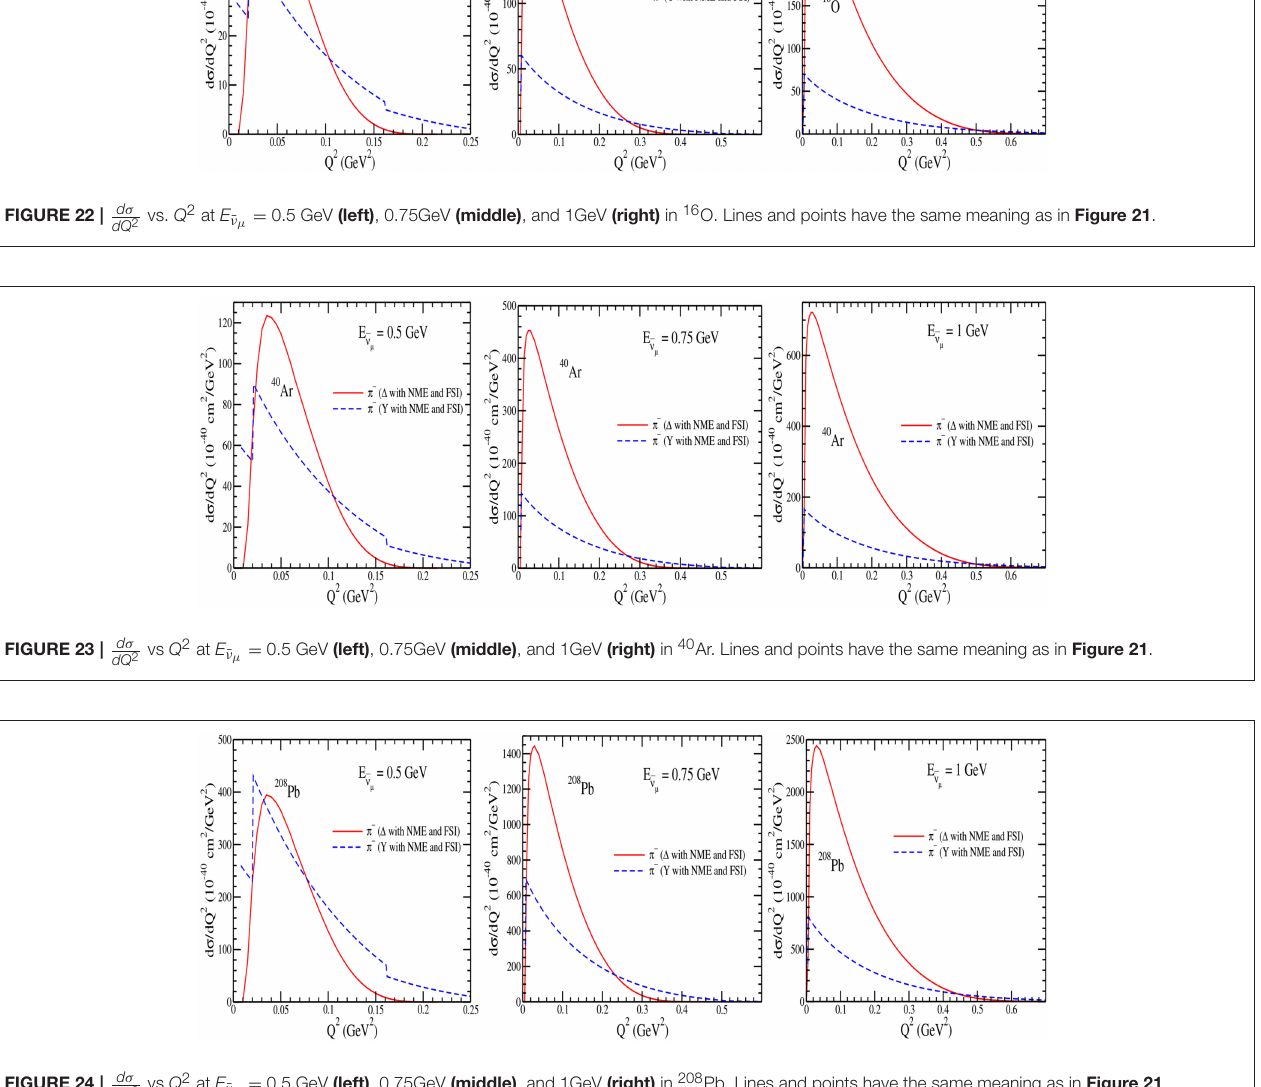
Frontiers in Physics |